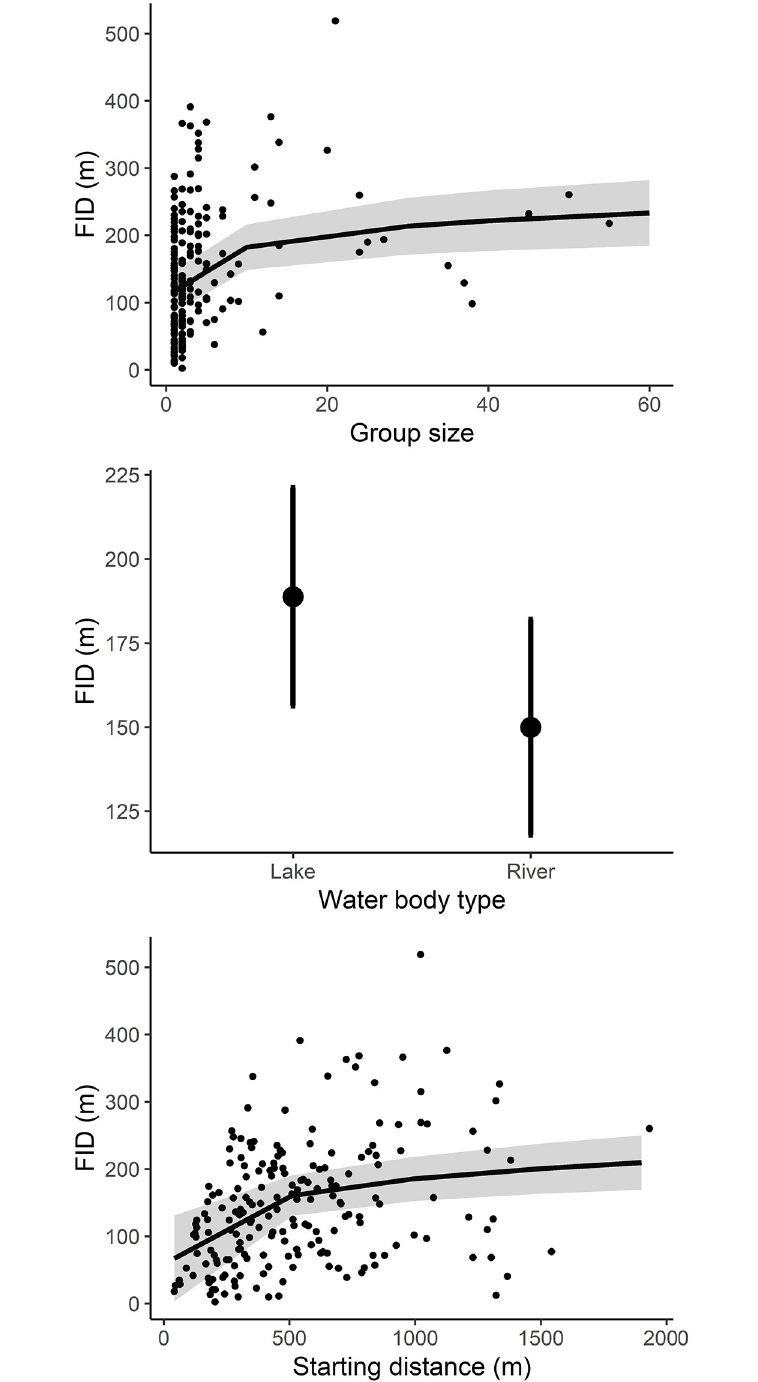
Fig 2. The predicted flight initiation distance (FID) of waterbirds ( n = 196 approaches) in relation to the group size (top), the water body type (middle), and the starting distance (bottom) in southeast Norway in 2015 and 2016. Grey shading represents 95% confidence